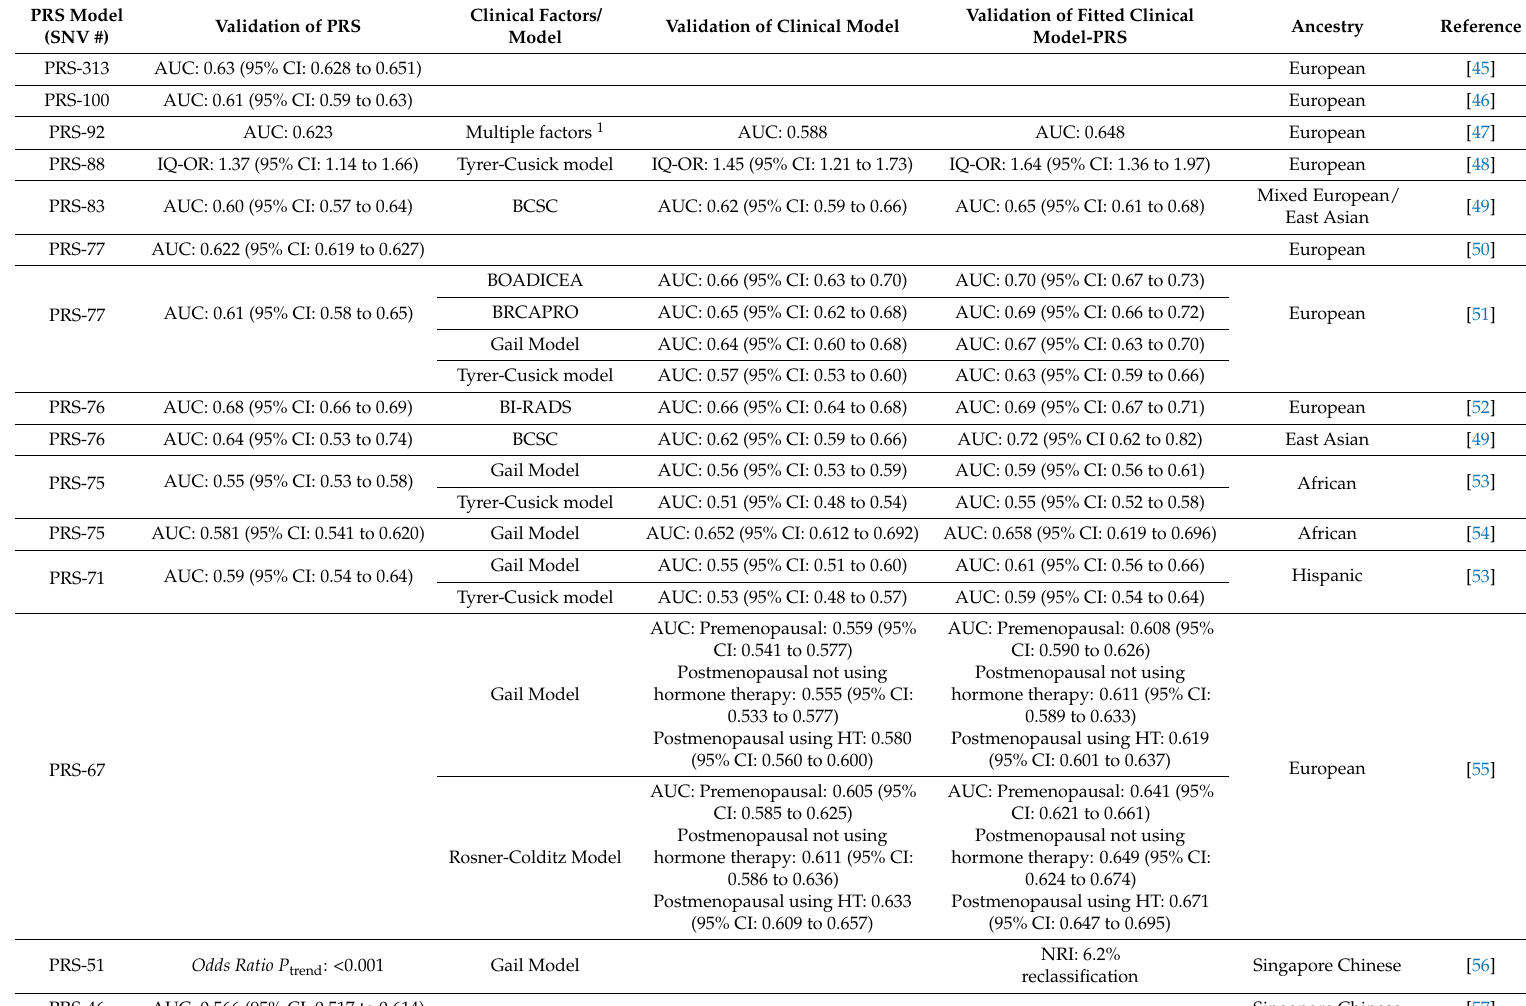
Table 1. Validations of polygenic and clinical breast cancer risk prediction